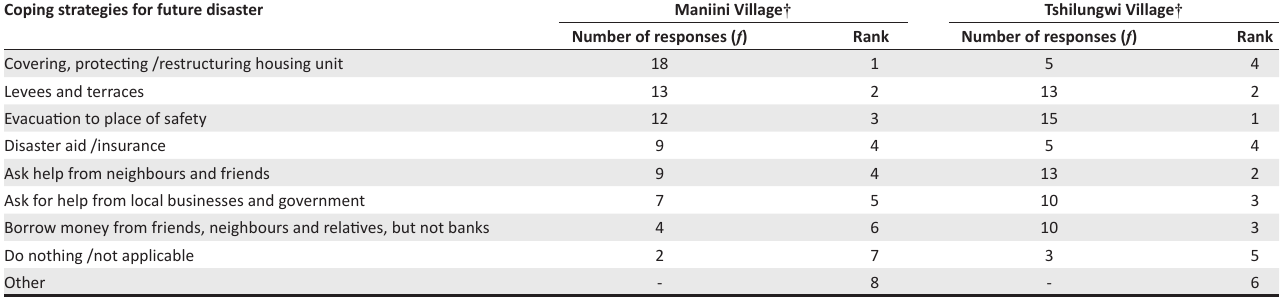
FIGURE 7: Annual income profile of households in Maniini and TABLE 2: Multiple-response ranking of households’ strategies of coping with the floods in Maniini and Tshilungwi Villages. Coping strategies for future disaster